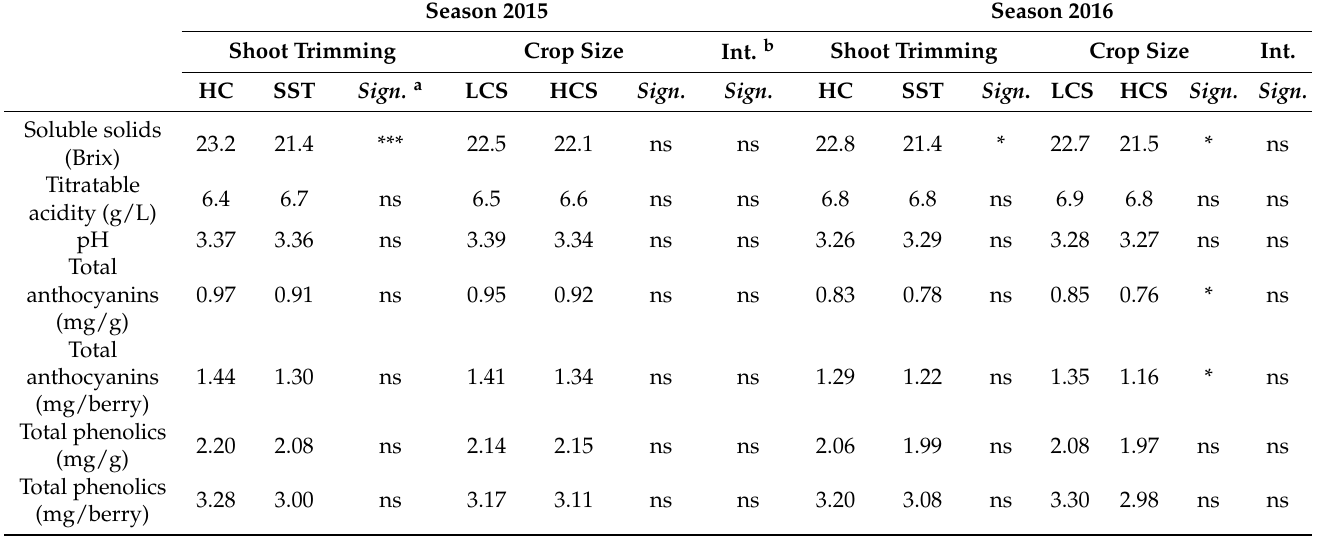
Table 6. Berry composition of Merlot grapevines subjected to two different trimming heights (HC, high canopy and SST, severe shoot trimming) and two different crop sizes (LCS, low crop size and HCS, high crop